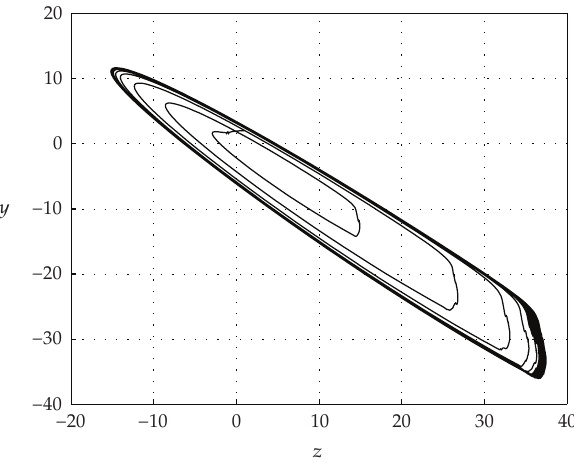
Figure 5: Solution curves for R 0 (cid:8) 0 . 25 with initial value (cid:5) 1 , 2 (cid:6)